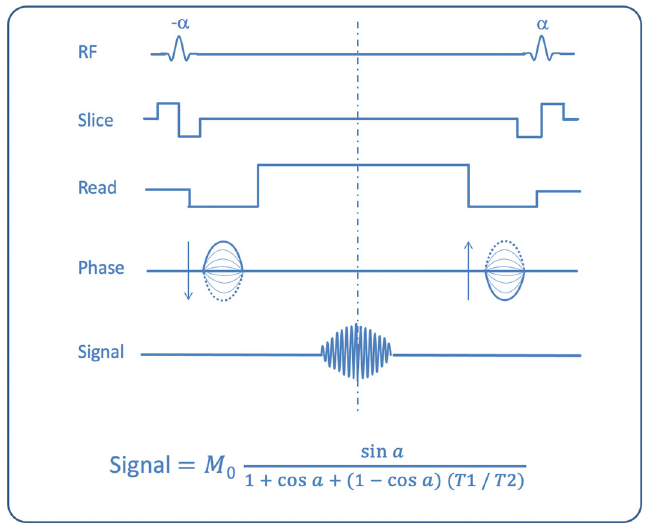
Figure 1. Scheme of a balanced Steady State Free Precession MR sequence, where balanced gradients along all three axes (slice-selection, phase-encoding, frequency-encoding) are used. In the formula (Huang et al., [5]), provided TR is much shorter than T1 and T2 of the tissue, it can be noted how signal intensity is directly related to the T2/T1 ratio at large flip angles. TR: repetition time; M0: magnetization at thermal equilibrium; α : flip